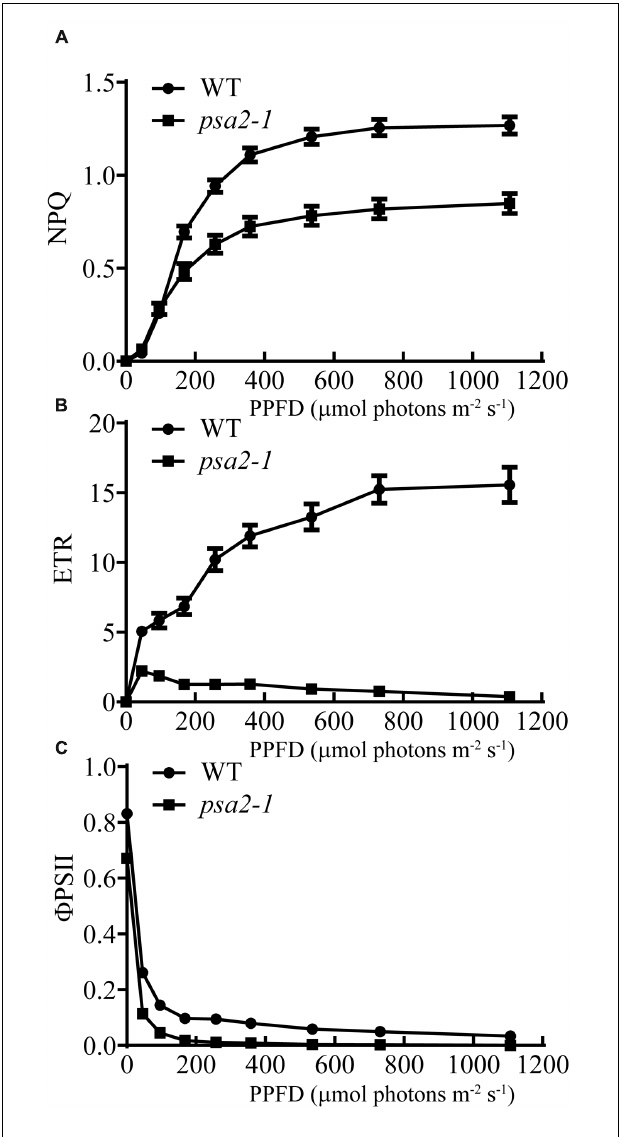
FIGURE 9 | Light-responsive curves of the non-photochemical quenching (NPQ) (A), photosynthetic electron transport rate (ETR) (B) and PSII quantum yield ( (cid:56) PSII) (C) in the wild-type (WT) and psa2-1 seedlings. The measurements were taken at the following photosynthetically active photon flux densities (PPFD): 0, 46, 96, 168, 257, 358, 535, 731, and 1,107 µ mol photons m − 2 s − 1 . Data represent means ± SE ( n =